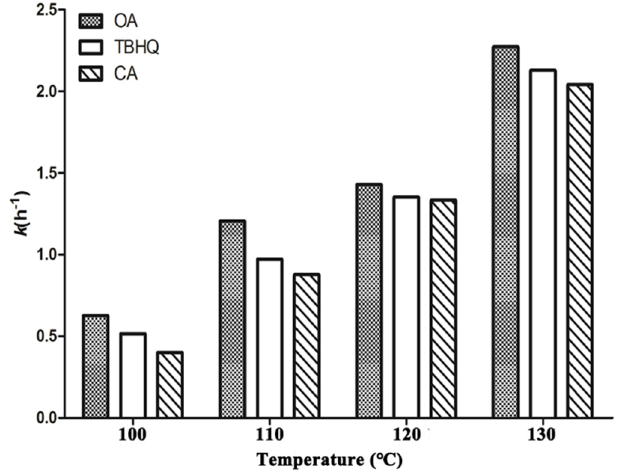
Figure 4. Kinetic rate constant ( k ) of the oxidation of OA, TBHQ + OA and CA + OA. From the perspective of the activated complex theory, Δ H and Δ S exhibited a positive relationship with the thermal oxidation rate of oils [55]. Based on the data listed in Table S6, the plots of ln ( k /T) versus 1/T were first established for OA, CA + OA and TBHQ + OA from 100 to 130 °C (Figure S1). The corresponding equations could be expressed as: y = − 5.6975x + 8.9535, R 2 = 0.9528; y = − 6.5083x + 10.912, R 2 = 0.9860; y = − 7.5879x + 13.594, R 2 = 0.9770. According to the equation of ln ( k /T) = ln ( k B / ℎ ) + ( Δ S/R) − ( Δ H/RT), Δ H of OA, TBHQ + OA and CA + OA were calculated to be 47.37, 54.11 and 63.09 kJ/mol, and Δ S were − 103.95, − 87.66 and − 65.36 J/mol K, respectively. The higher Δ H and Δ S of TBHQ